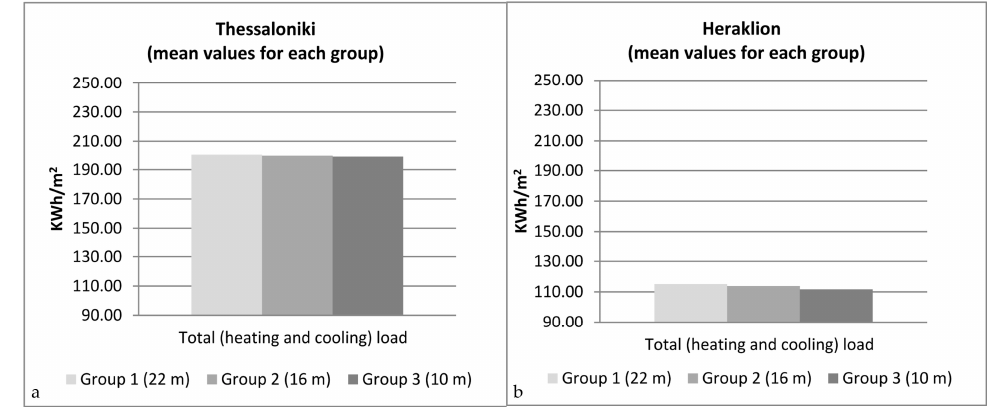
Figure 10. Histogram presenting mean values for the cooling loads calculated for each group of urban blocks for the climatic conditions of ( a ) Thessaloniki and ( b ) Heraklion.